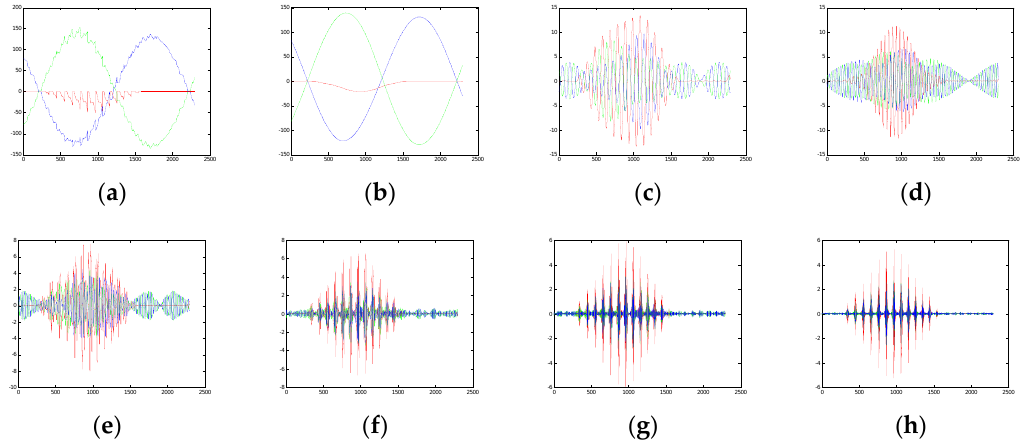
Figure 6. Waveforms of three-phase current and the mode coefficients serials under No. 2 failure state. ( a ) Waveform of three-phase current. ( b – h ) Waveforms of mode coefficients serials from 1st level to 7th level.